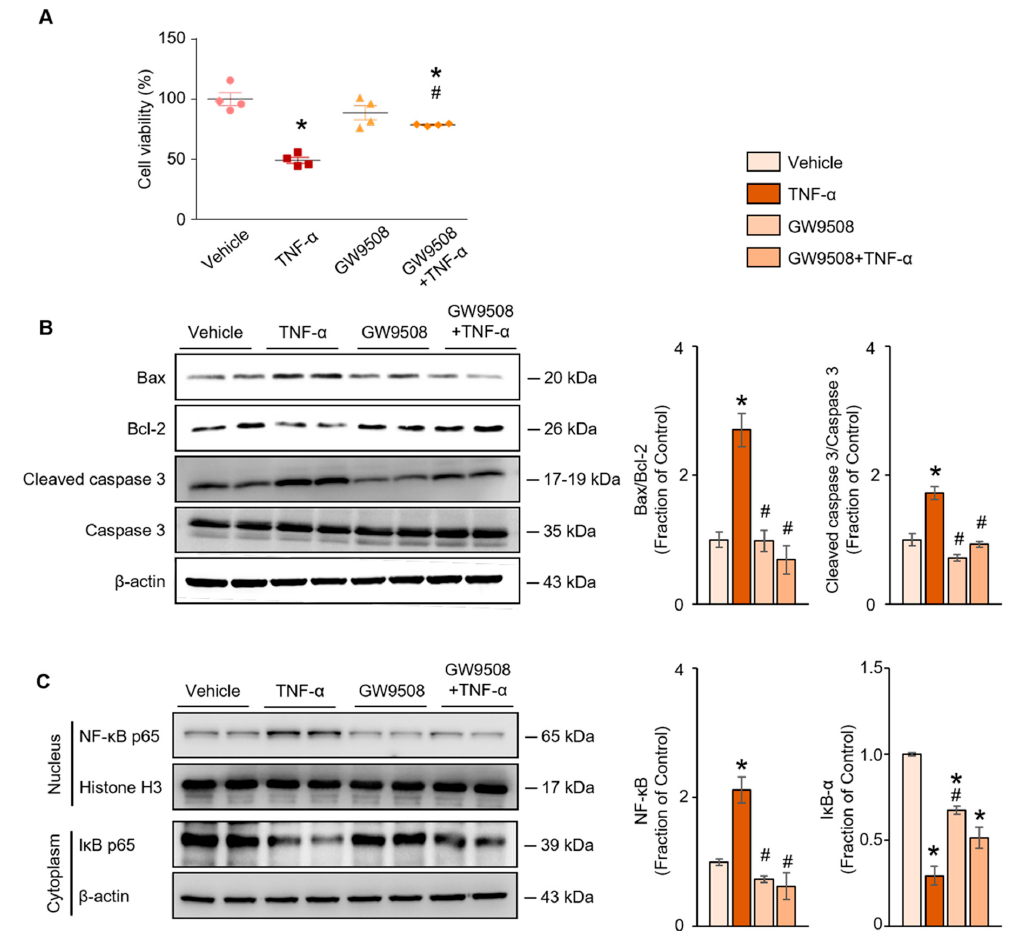
Figure 4. ( A ) Cell viability assay, ( B ) Western blot analyses of the levels of pro-apoptotic proteins (Bax, Bcl-2 and cleaved caspase-3) and ( C ) nuclear translocation of the NF- κ B p65 subunit in tumor necrosis factor (TNF)- α -treated rat proximal tubular (NRK52E) cells with or without pretreatment with GW9508, a G-protein-coupled receptor 40 agonist. The representative Western blot and the quantitative data are presented. Shown are representative blots from three separate experiments with similar results. The data are expressed as means ± SEM. * p < 0.05 compared with vehicle-treated NRK52E cells. # p < 0.05 compared with TNF- α -treated NRK52E cells. Alterations in AT1R protein expression, TNF- α mRNA levels and ROS generation were examined to determine the mechanisms of TNF- α -induced tubular injury. All of these factors were increased by treating NRK52E cells with TNF- α . Notably, we observed that these TNF- α -stimulated changes were attenuated by pretreatment with GW9508 (Figure 5A–C).